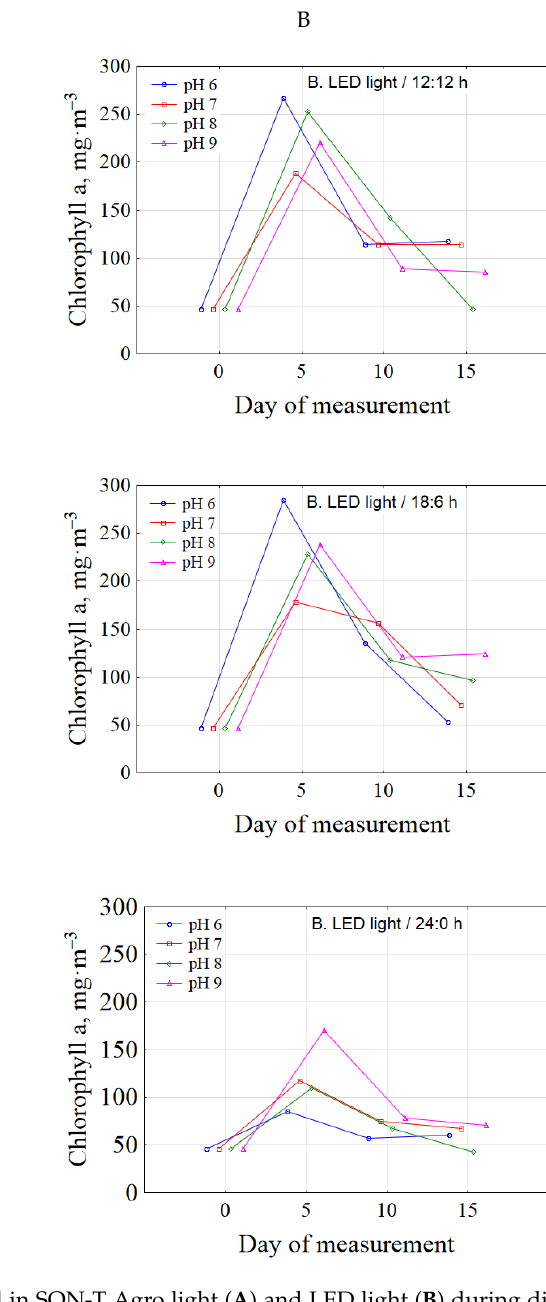
Figure 5. Dynamics of chlorophyll a content in microalgal in SON-T Agro light ( A ) and LED light ( B ) during different light:dark cycle.